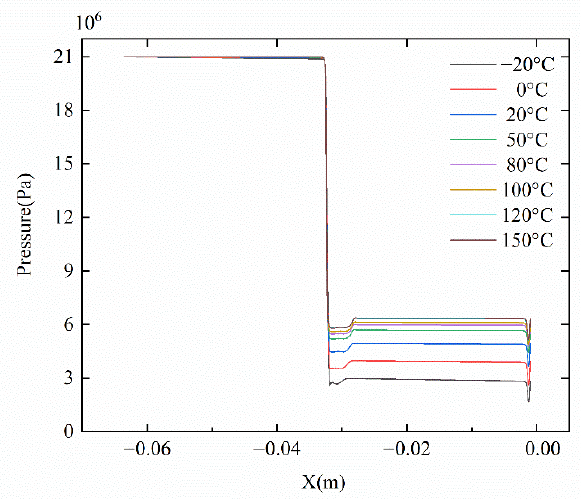
Figure 12. Axial pressure distribution at the centerline of the AI